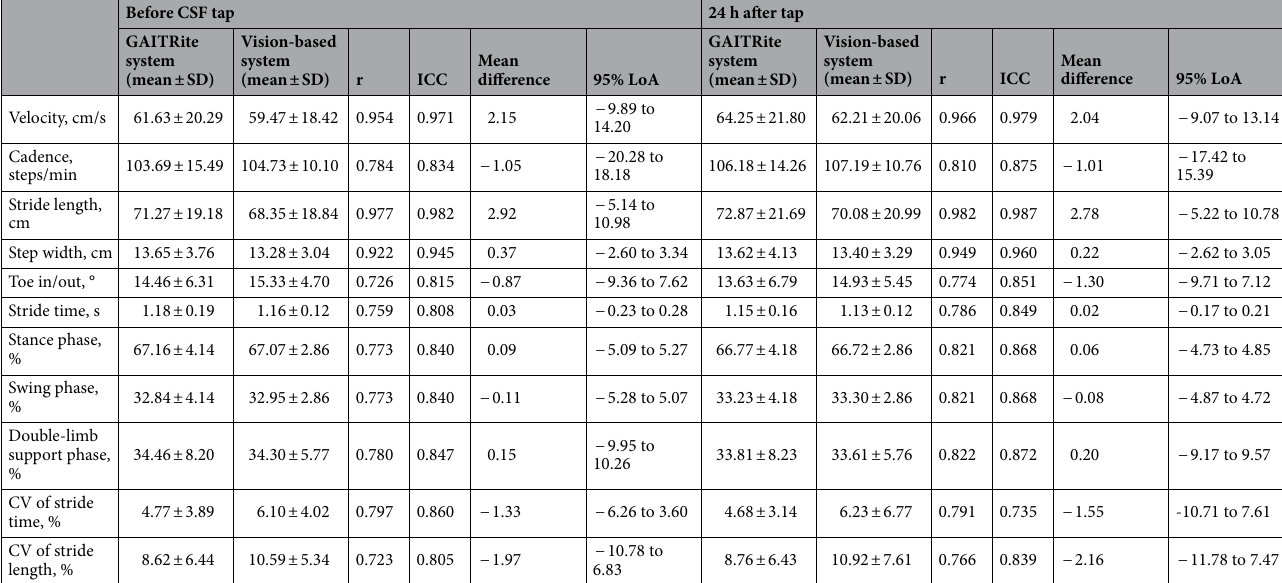
Table 2. Concurrent validity between the vision-based gait analysis system and the GAITRite gait analysis system for temporo-spatial gait parameters. CSF, cerebrospinal fluid; ICC, intraclass correlation coefficient; 95% LoA, 95% limits of agreement; CV, coefficient of